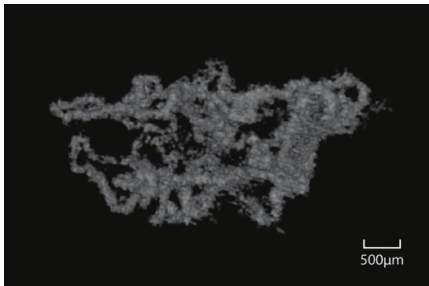
Figure 8: A 3D, volume-rendered and segmented image of the radio-opaque malpighian tubules in C.